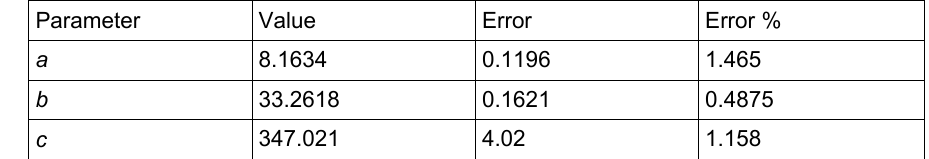
Table 3 – Fit parameters for the peak in Figure 4 Таблица 3 – Согласованные параметры пика на рис . 4